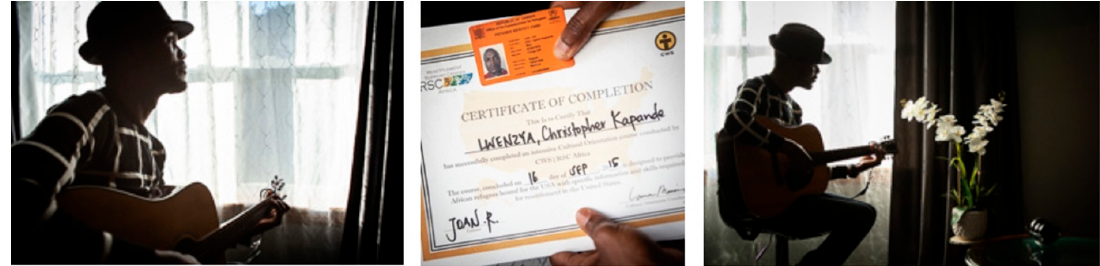
Figure 7. Christopher. After fleeing unspeakable violence and atrocities in the Democratic Republic of Congo, Christopher lived for years as a refugee in Zambia until he and his wife and children were granted admission to the U.S. At the opening reception for the exhibit, Christopher and Colin performed Congolese music together, with researchers, RRBs, service providers, and other attendees as the audience. This is one of a number of instances of social capital being developed through the project.